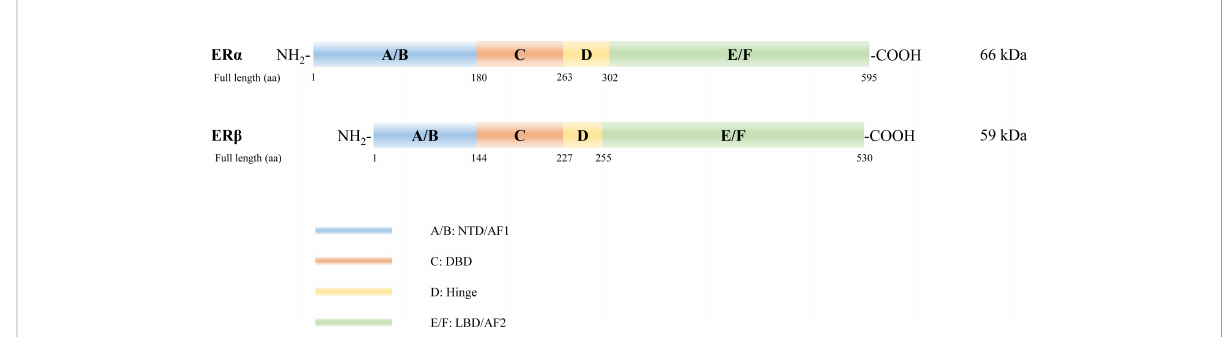
FIGURE 1 Structure of estrogen receptors (ERs). Six structural and functional domains are highlighted: A, B domain (amino-terminal or NH 2 -terminal domain [NTD], activation function 1 [AF1]); C domain (DNA binding domain [DBD]); D domain (hinge region connecting the C and E domain); E, F domain (carboxyl- or COOH-terminal, ligand-binding domain [LBD],